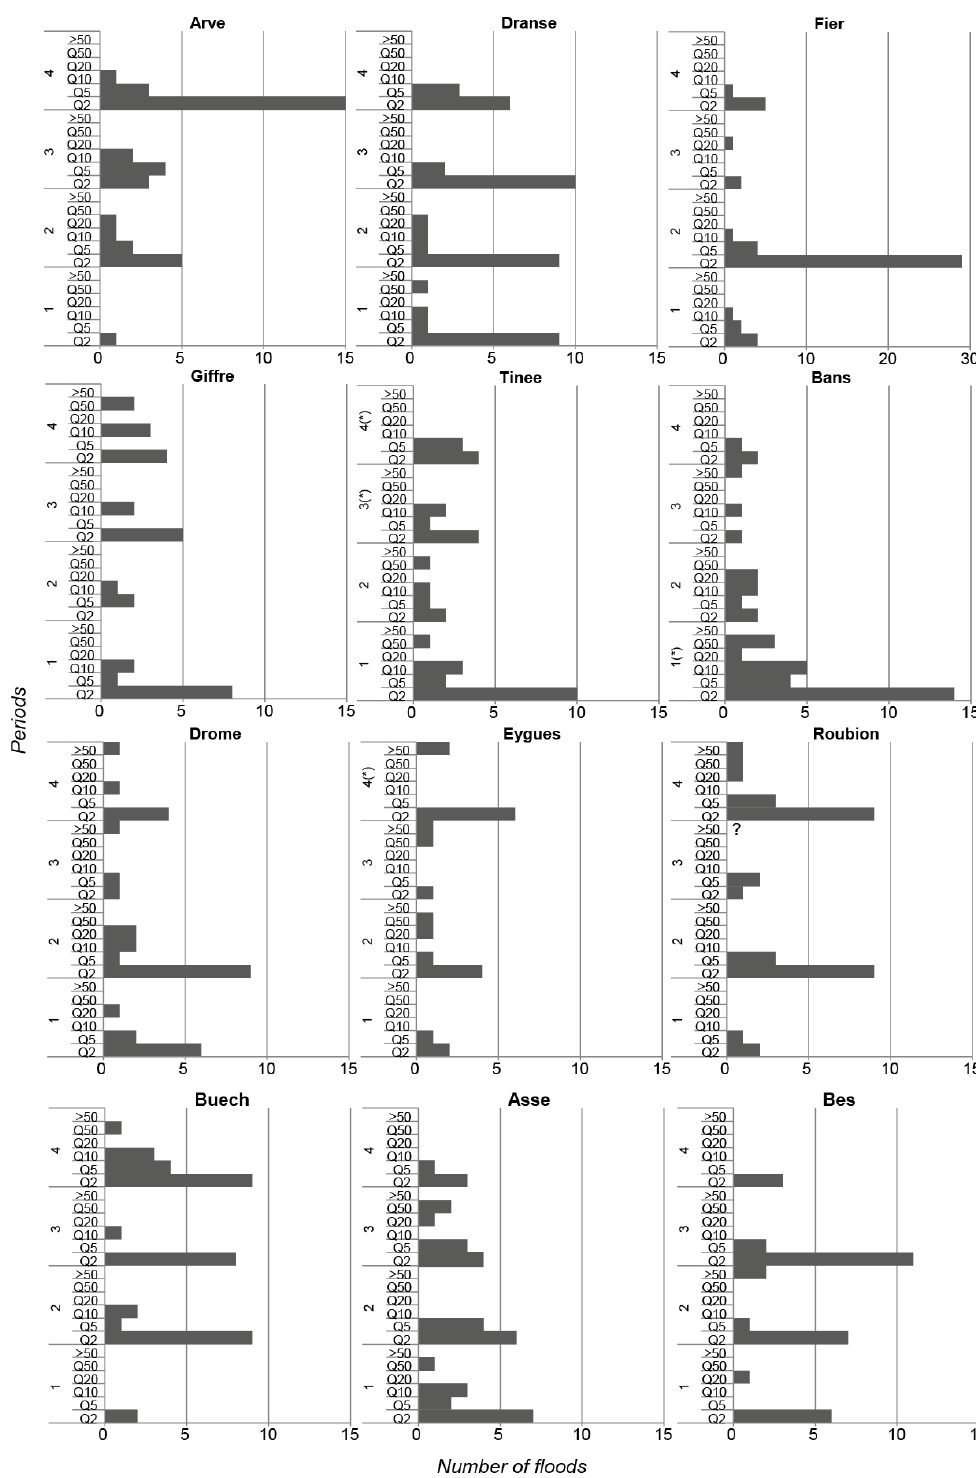
Fig. 3. The number of floods (all return periods) occurring at each period (1 to 4) for all selected reaches. Period 1 = 1950/60–1970; Period 2 = 1970–1980; Period 3 = 1980–1990; Period 4 = 1990–2000). Data for periods (*) are taken on other stations situated upstream or downstream on the main stem (the Tinee since 1991) or on a different river in the same hydro-geographical area (the Bans before 1978 and the Eygues after 1996). For the Roubion, “?” corresponds to the large flood occurring in 1994 when no data series were recorded.